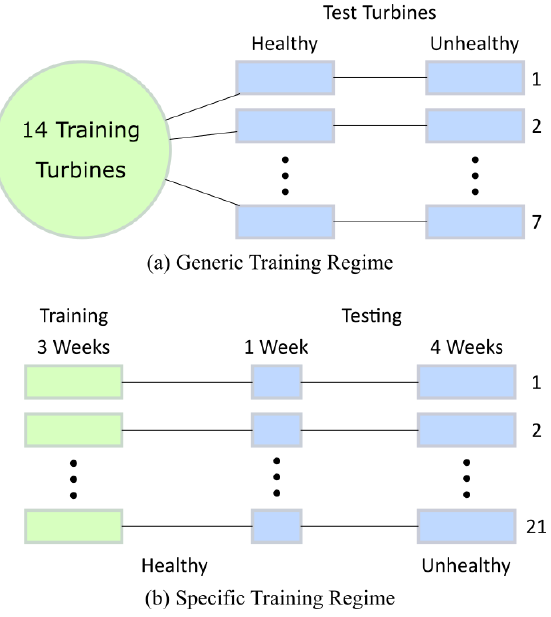
Figure 2. The training regimes used in this